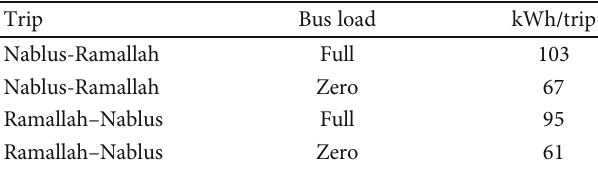
Table 1: Energy consumption per trip for the adapted runs.